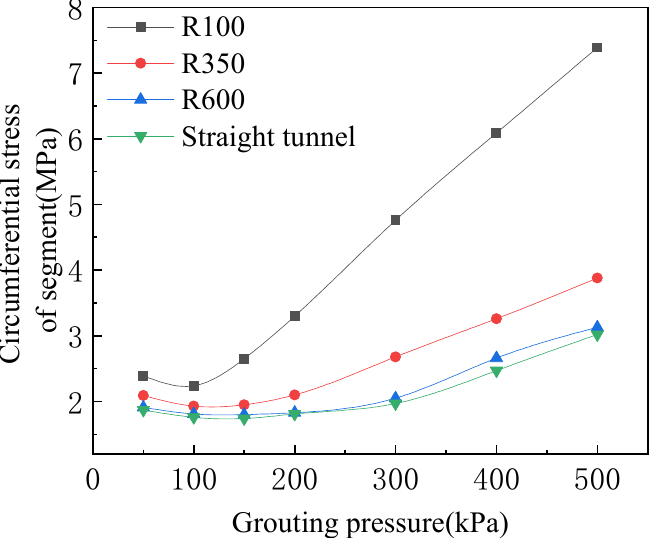
Figure 16. Variation curve of the maximum circumferential stress of the segment with the grouting pressure. It can be seen from Figure 15 that the grouting pressure has a great influence on the longitudinal tensile stress of the segment when the tunnel is excavated. The longitudinal tensile stress of the segment increases with the increase in the grouting pressure, and the two have an obvious nonlinear relationship. When the grouting pressure is constant, the maximum longitudinal tensile stress of the segment increases with the decrease in the curve radius; especially when the tunnel radius is 100 m, the longitudinal tensile stress of the segment increases rapidly. When the grouting pressure is 200 kPa, the maximum longitudinal tensile stress with a curve radius of 100 m, 350 m, 600 m, and the straight tunnel is 3.29 MPa, 2.12 MPa, 2.05 MPa, and 1.98 MPa, respectively. The longitudinal tensile stress of the segment corresponding to the curve radius of 100 m, 350 m, and 600 m increased by 66.16%, 7.07%, and 3.54%, respectively. The reason is that when the curve radius is smaller, the jack force in the shield tunneling process is not related to the segment. The larger the direction angle is, the more the uneven force on the segment will cause additional stress on the segment.